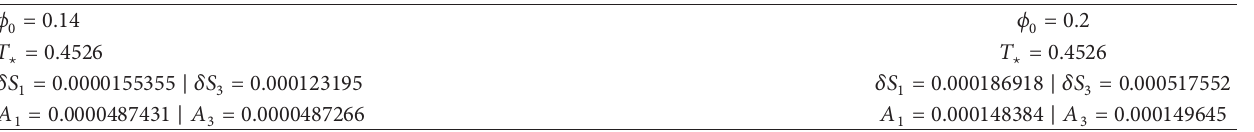
Figure 9: Relation between the entanglement entropy and temperature in the fixed charge ensemble for different charges at 𝜙 0 = 0.14 . The red solid line corresponds to the location of the minimum temperature 𝑇 0 ; the dashed lines in (a), (b), and (c) correspond individually to the locations of Hawking-Page phase transition 𝑇 1 , first-order phase transition 𝑇 ⋆ , and second-order phase transition 𝑇 𝑐 . Table 2: Check of the equal area law in the 𝑇 - 𝛿𝑆 plane for different 𝜙 0